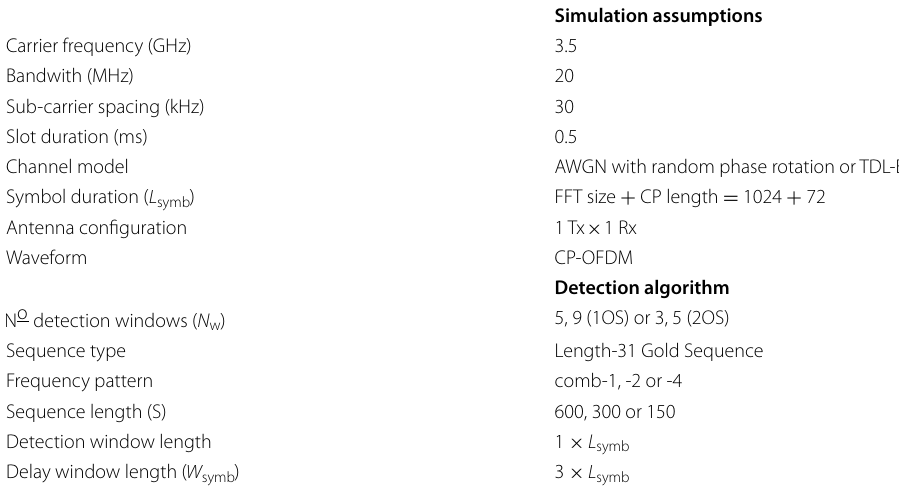
Table 3 Physical layer parameterization and detection algorithm